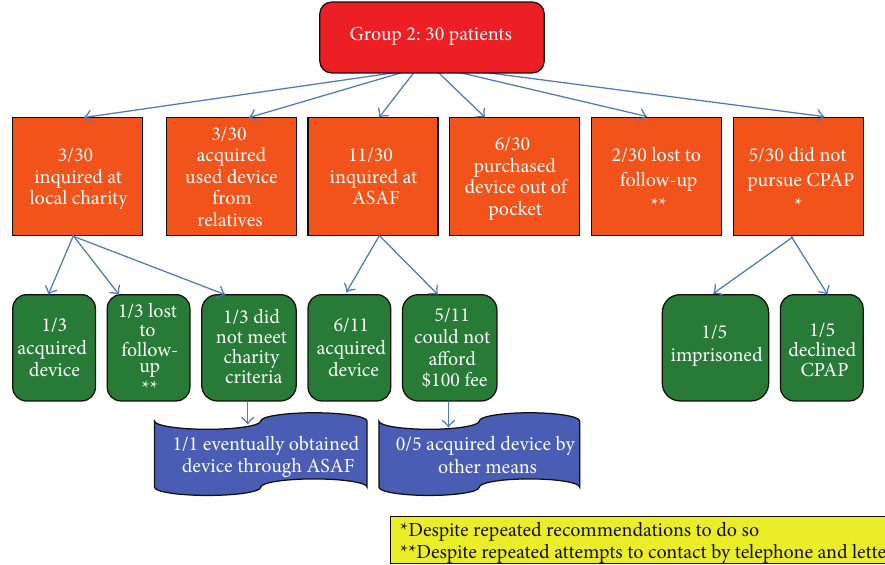
Figure 2: Attempts at CPAP acquisition in 30 disadvantaged, uninsured patients (Group 2). ASAF: American Sleep Apnea Foundation, a charity organization that supplies CPAP devices to those who may not be able to otherwise afford one, for a one-time application fee of $100 at the time of this